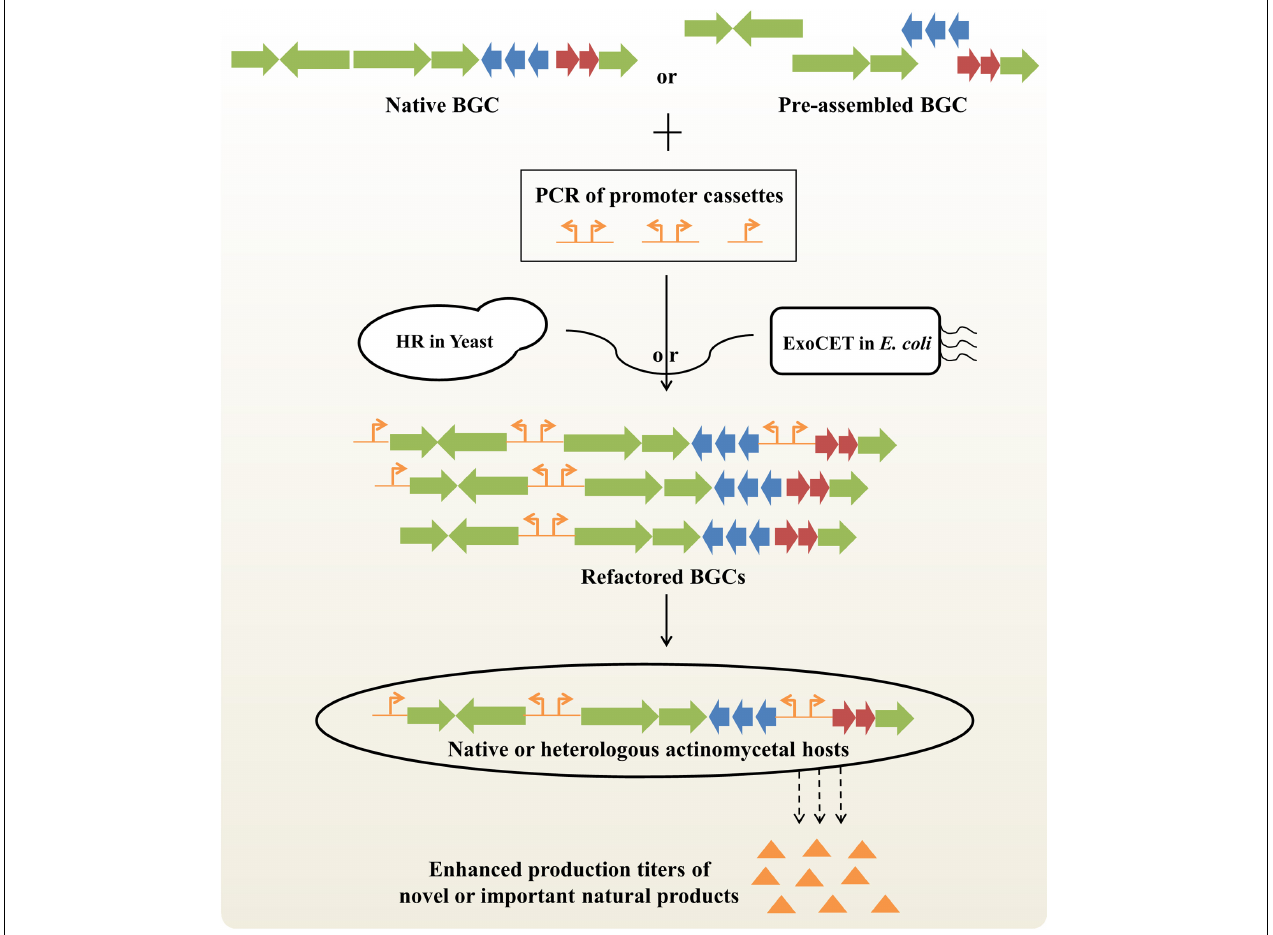
FIGURE 3 | Improved production titers of novel or important natural products by BGC refactoring strategy. Native BGCs can be obtained by in vivo or in vitro BGC cloning/assembly strategies. Preassembled BGC can be obtained by PCR amplification or CRISPR-mediated in vitro digestion of native BGCs. Refactored BGCs can be obtained by partial or complete replacement of native promoters with artificial promoters based on homologous recombination (HR) in S. cerevisiae or exonucleases combined with RecET recombination (ExoCET) in E. coli . Finally, different refactored BGCs will be integrated into native or heterologous actinomycetal hosts for activating silent BGCs or enhancing production titers of clinically important drugs. BGC, biosynthetic gene